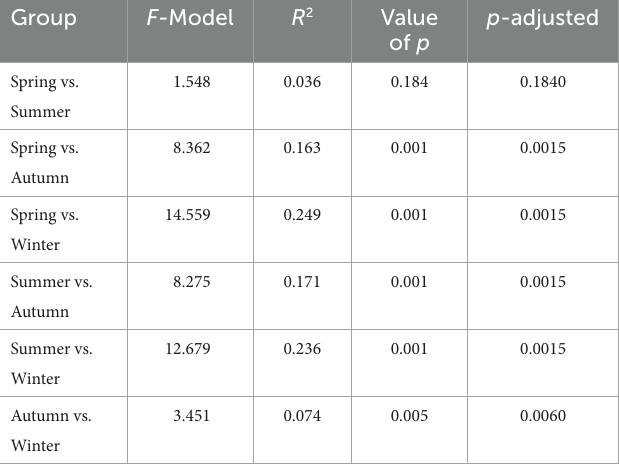
TABLE 2 Statistical analysis (PERMANOVA) of food mass seasonal difference of plant items consumed by wild golden snub-nosed monkeys